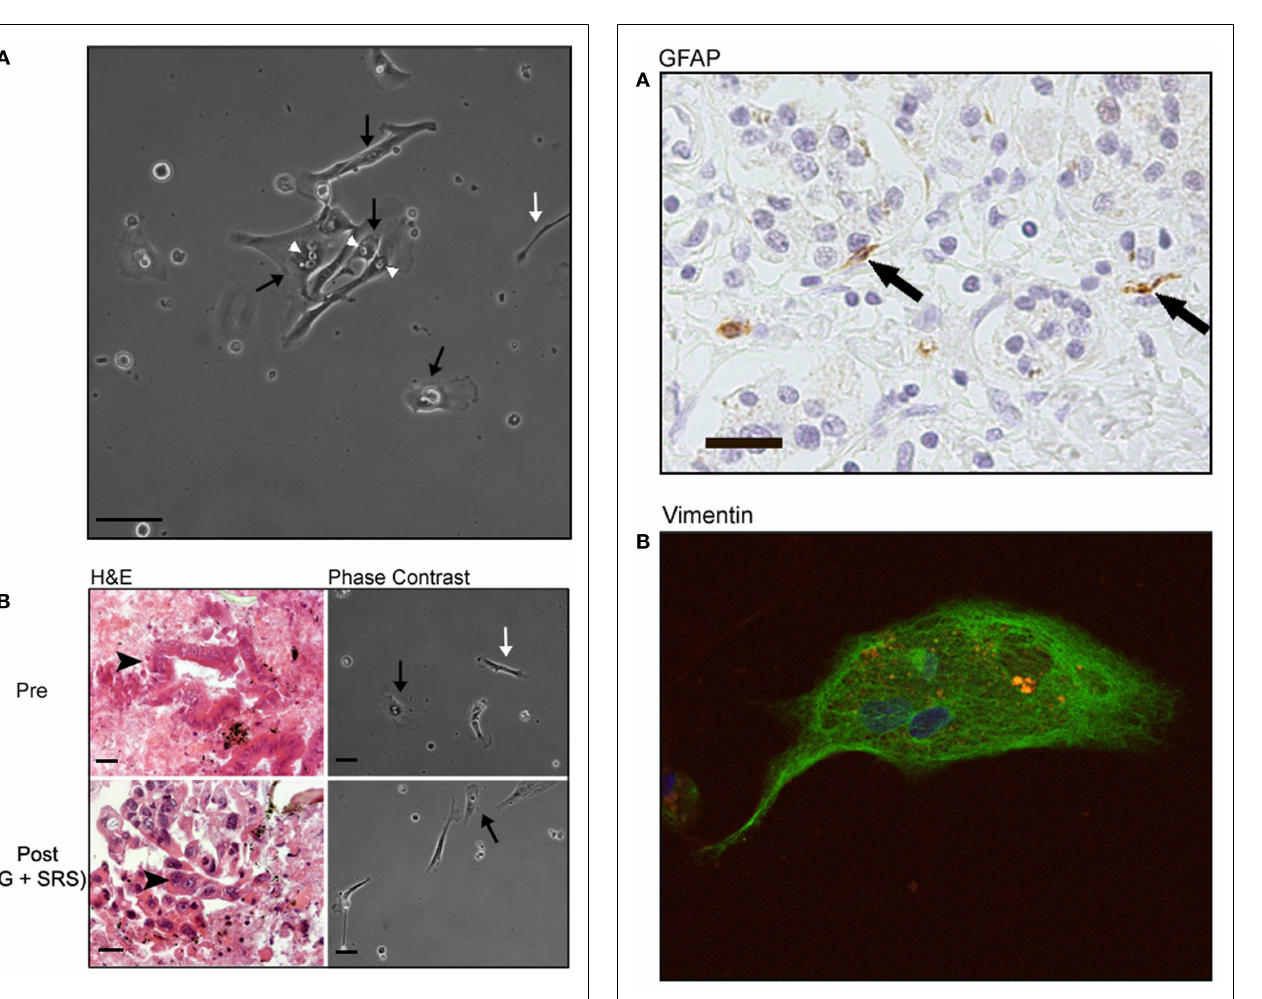
FIGURE 4 | Immunohistochemical staining of human tumor-derived pancreatic stellate cells . (A) Representative sections of pancreatic adenocarcinoma with positive staining of glial fibrillary acidic protein (GFAP) (black arrows). Scale bar: 20 µ m. (B) Representative immunofluorescence staining of human tumor-derived pancreatic stellate cells with positive vimentin expression (FITC green) and auto-fluorescent cytoplasmic lipid droplets (orange). Nuclei counterstained with